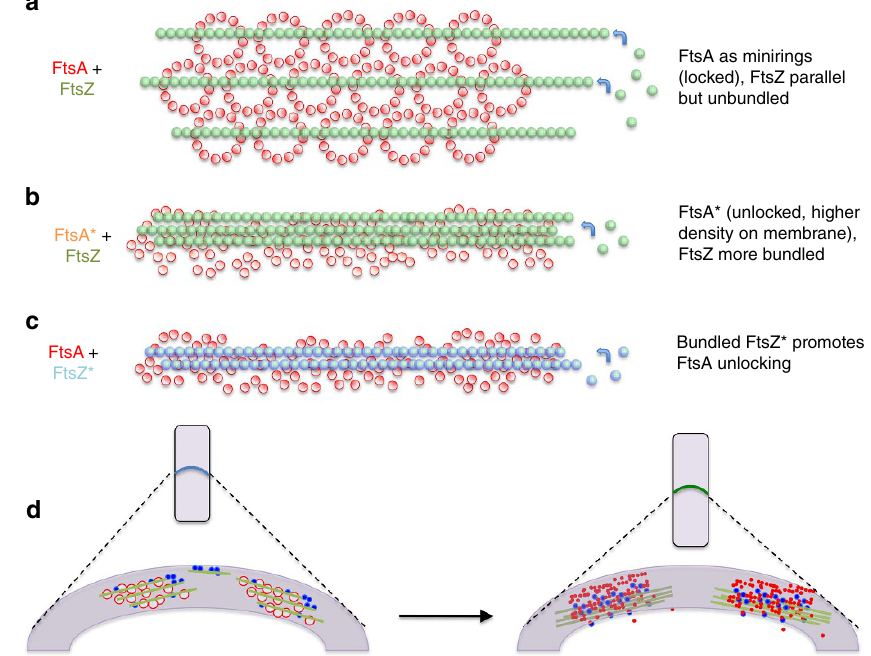
Figure 7 | Proposed model for FtsA miniring functions. We propose that FtsA minirings may align FtsZ protofilaments and inhibit their bundling until the minirings are disrupted. ( a ) FtsZ protofilaments (green) are initially kept apart in an unbundled state by membrane-bound FtsA minirings (red). This form of FtsA is toxic to cells when in excess because unbundled FtsZ cannot assemble into an active FtsZ division ring needed for later stages in septation. ( b ) FtsA* (orange) on lipid monolayers displays abundant curved oligomers but full minirings are rare, in agreement with genetic evidence indicating that FtsA* is in a more monomeric state than FtsA. Unlike FtsA, lipid-bound FtsA* promotes lateral interactions among FtsZ protofilaments (green), probably because FtsA* oligomers are more randomly and tightly packed on the membrane, removing the geometric constraints imposed by FtsA minirings on FtsZ protofilament assembly and promoting the natural tendency of membrane-tethered FtsZ protofilaments to associate laterally. We speculate that this ‘unlocked’ FtsA* is not toxic to cells when in excess because FtsZ bundling is needed for activity of the septal ring. Cells with FtsA* may bypass the initial step ( a ) and proceed directly to active septation. ( c ) Adding physiological levels of FtsZ* (blue) to lipid monolayers seeded with FtsA (red) results in FtsA*-like structures on the membrane and no minirings, suggesting that the protofilament pairs of FtsZ* promote FtsA miniring disassembly. This is consistent with the FtsA*-like phenotype of FtsZ* in vivo , including the ability to bypass ZipA. FtsZ treadmilling (blue arrows) may occur in all three scenarios. ( d ) The ability of FtsA* to promote bundling of FtsZ protofilaments and the ability bundled FtsZ* protofilaments to disrupt FtsA minirings suggests that the increased FtsZ bundling and decreased higher order structures of FtsA are self-reinforcing and therefore irreversible. Because FtsA* accelerates cell division in vivo and can suppress defects in other cell division proteins, we propose that bundling of FtsZ protofilaments (green) by conversion of FtsA minirings (red circles) into shorter FtsA oligomers (red), aided by ZipA and Zap proteins (blue), may be crucial for septal ring activity, and is consistent with evidence that FtsZ filaments become more dense as the Z ring